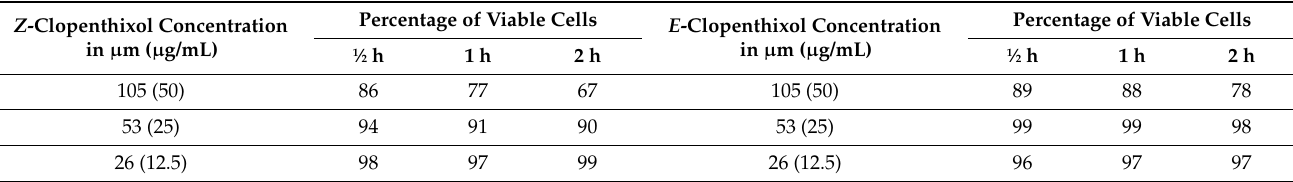
Table 10. Effect of Z- and E-clopenthixol on human neutrophil viability, determined by trypan blue dye exclusion after 1 ⁄ 2 , 1, and 2 h incubation at 37 ◦ C in GBSS containing 0.5% human serum albumin. Results are mean percentage of viable cells from 2–3